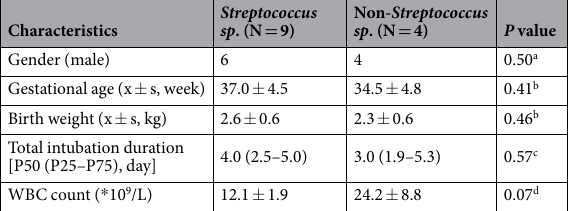
Table 6. Comparison of demographic and clinical characteristics between the Streptococcus sp . and the non- Streptococcus sp . groups among pneumonia patients with VAP in the study. a Based on Fisher’s exact test. b Based